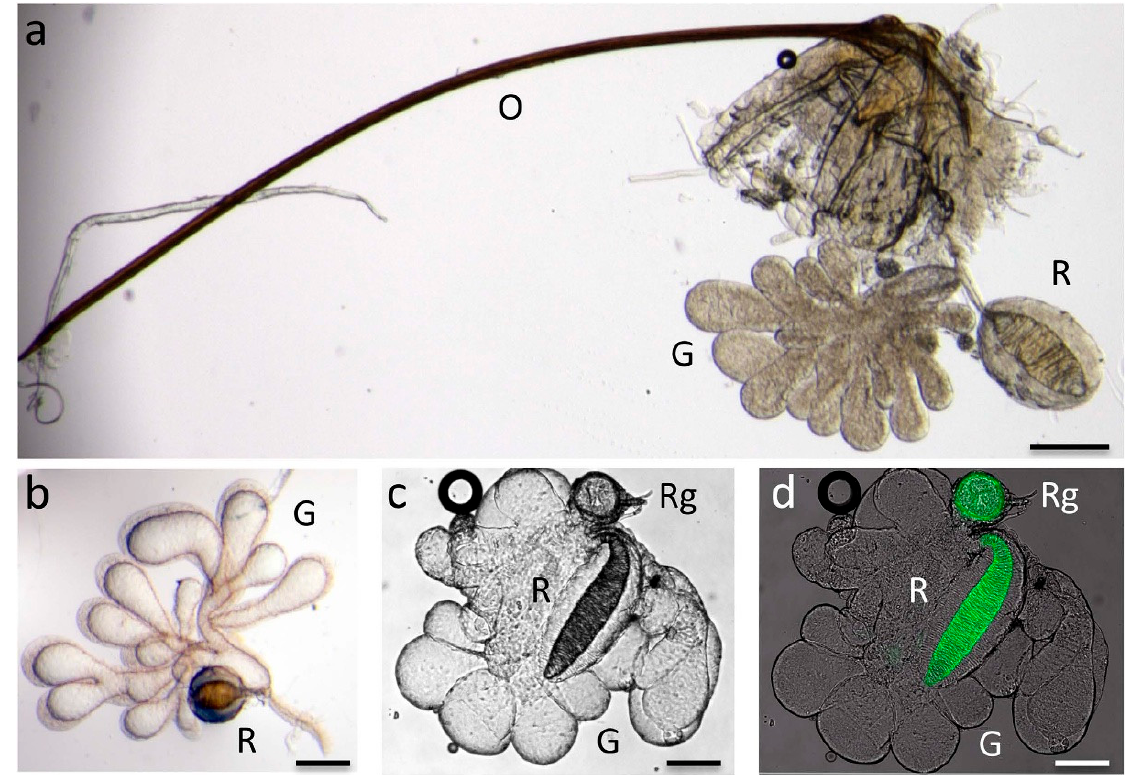
Figure 3. Venom apparatus of two Psyttalia species: ( a ) P. lounsburyi female venom apparatus composed of a multi-lobed gland (G), a reservoir (R) and a long ovipositor (O); ( b ) Dissected P. lounsburyi venom gland showing the thick tissue envelope of the gland and the basal lateral branching of the reservoir; ( c ) P. concolor venom apparatus evidencing the small round gland at the base of the apparatus (Rg); ( d ) the same, overlaid with a fluorescence micrograph showing the green auto-fluorescence of the internal spirals of the reservoir and the small round gland. Bars = 100 μ m. (Source: from [55] reproduced under the terms of Creative Commons Attribution Licence CC-BY 4.0 via Scientific Reports ).